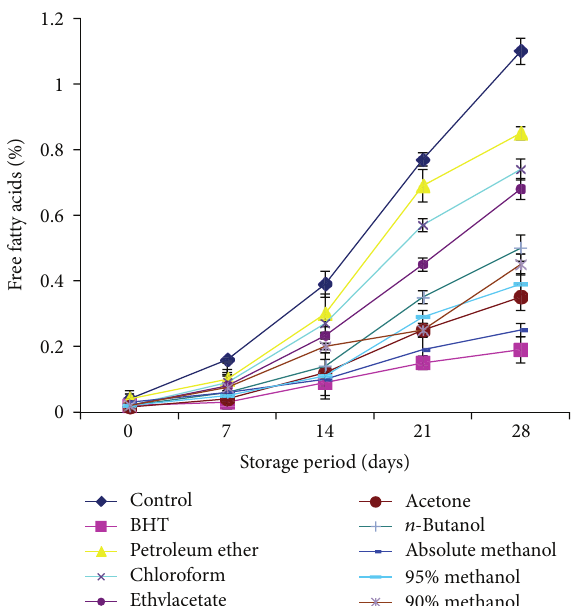
Figure 4: Relative increase in p -ansidine values of sunflower oil stabilized with C. viminalis leaves extracts.